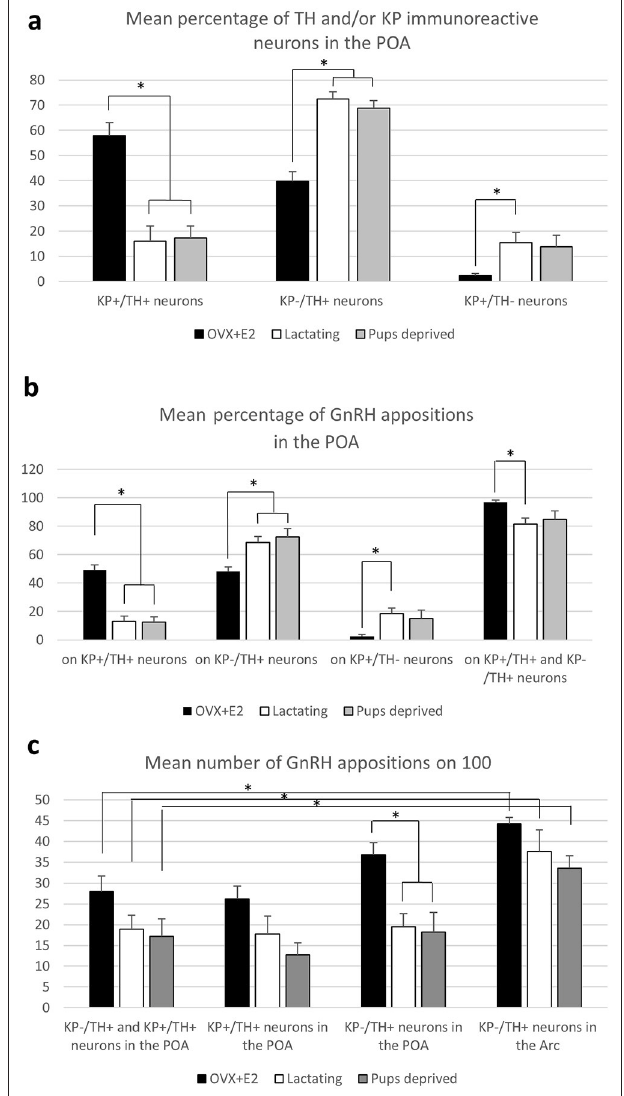
FIGURE 5 | Characterization of preoptic and arcuate TH-IR neurons for kisspeptin expression and GnRH-IR afferentation. (a) Percentage of neurons immunoreactive (IR) for tyrosine hydroxylase (TH) and/or kisspeptin (KP) in the preoptic area (POA). (b) Percentage of the GnRH appositions on each of this neuronal phenotype in the POA. (c) The mean number of GnRH appositions on 100 TH-IR neurons in the POA and arcuate nucleus (Arc). Asterisks mark significant